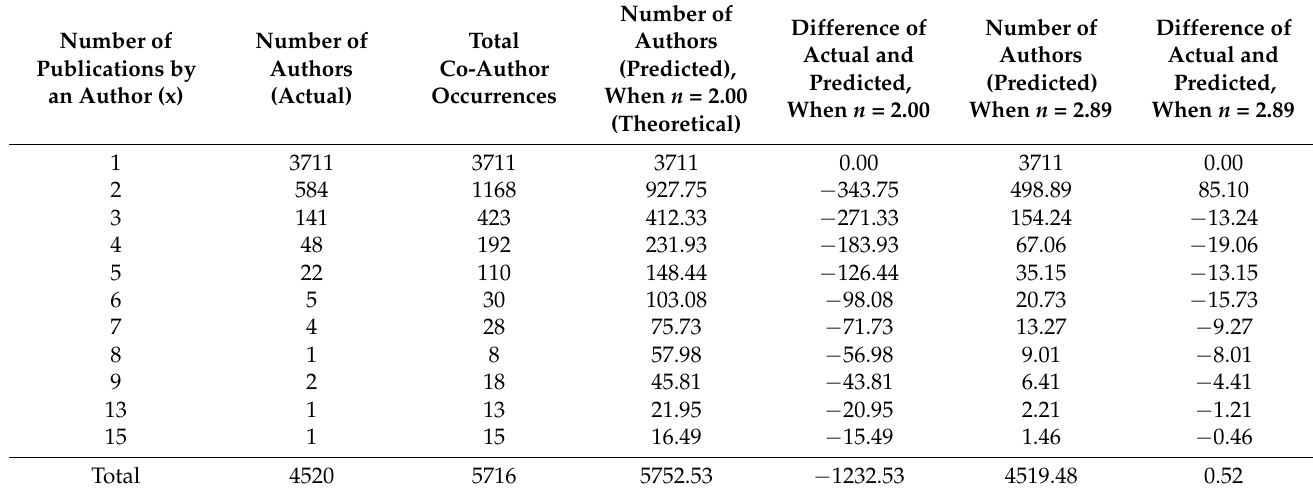
Table 5. Results of the author-based research productivity analysis by the Lotka’s law. A sample calculation for the subject area Art and